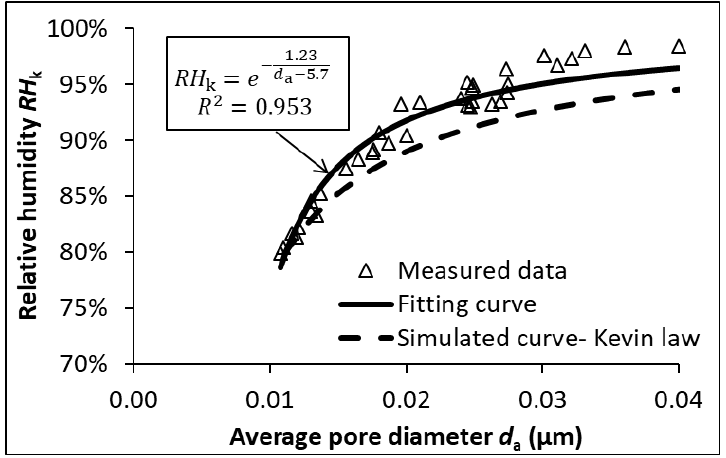
Figure 10. Relative humidity expressed as a function of average pore diameter. Table 5. Pore solution chemistry (mol/L) of cement pastes cured under sealed condition for 28 days.